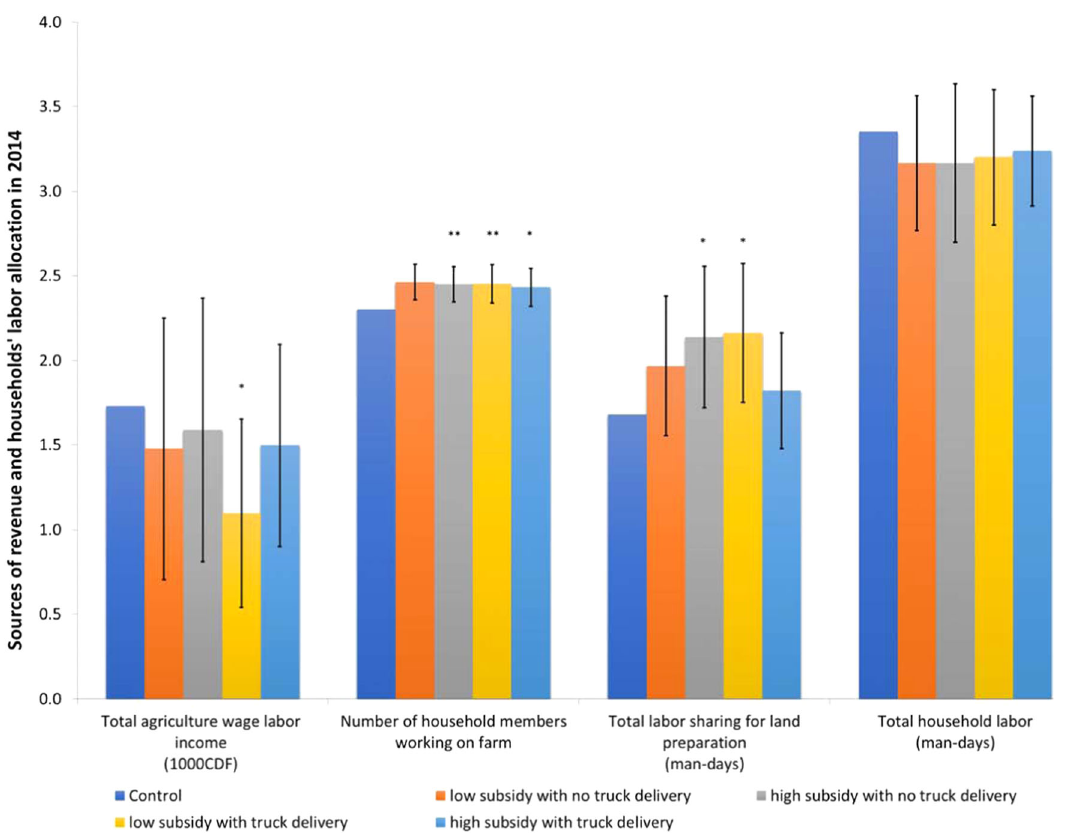
Fig. 5 | Households ’ labor allocation in 2014. Source: Follow-up survey wave 2014. Estimatesbased on n =839(bar cluster1), n =883(barcluster2)and n =902 (bar cluster 3 and 4) households living in the n =92 independent villages included intheexperiment.Note:Barcluster1showsthetotalincomeearnedbyhousehold membersforagriculturewagelabor,barcluster2showsthenumberofhousehold membersworkingonthehouseholdfarm,barcluster3isatotalnumberofperson- days dedicated to land preparation for this household through labor-sharing arrangements, bar cluster 4 is the number of person-days for land preparation by householdmembers.Foralloutcomes,theinversehyperbolicsinetransformation is used (see Supplementary Information). Each bar represents the ordinary least